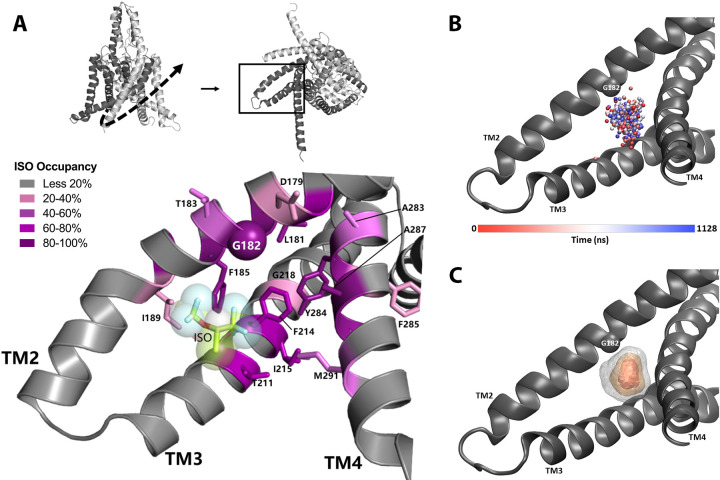
Molecular dynamics (MD) simulation studies define an isoflurane-binding pocket in TREK1 channels.(A) By rotating the TREK1 structure shown in Figure 2 (top left, dashed arrow), we demonstrate the region of TM2, TM3, and TM4 that forms the isoflurane-binding site (top right, boxed). Below, a representative MD simulation snapshot of the isoflurane binding pocket, highlighting the G182 residue (sphere) and additional positions found to exhibit high isoflurane occupancy (sticks). Relative isoflurane occupancy for each residue (see Table 1) is shown as quartiles, as described on left (B) Position of the oxygen atom at the center of the isoflurane molecule during equilibrium MD simulation trajectory 2 of mTREK1 WT in the presence of isoflurane (C) Density map of the position of the bound isoflurane. Isosurfaces represent 10% (gray), 30% (yellow), and 50% (orange) isoflurane occupancy.